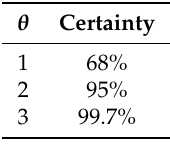
Table 2. Certainty that a threat is occurring based on the accuracy of the